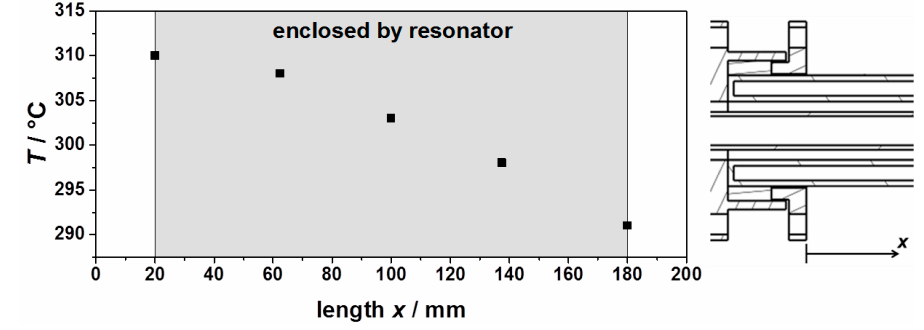
Figure 6. Temperature distribution inside the sample tube along its axis at a heating gas temperature of 430 °C. The sample tube is enclosed by the resonator in the gray